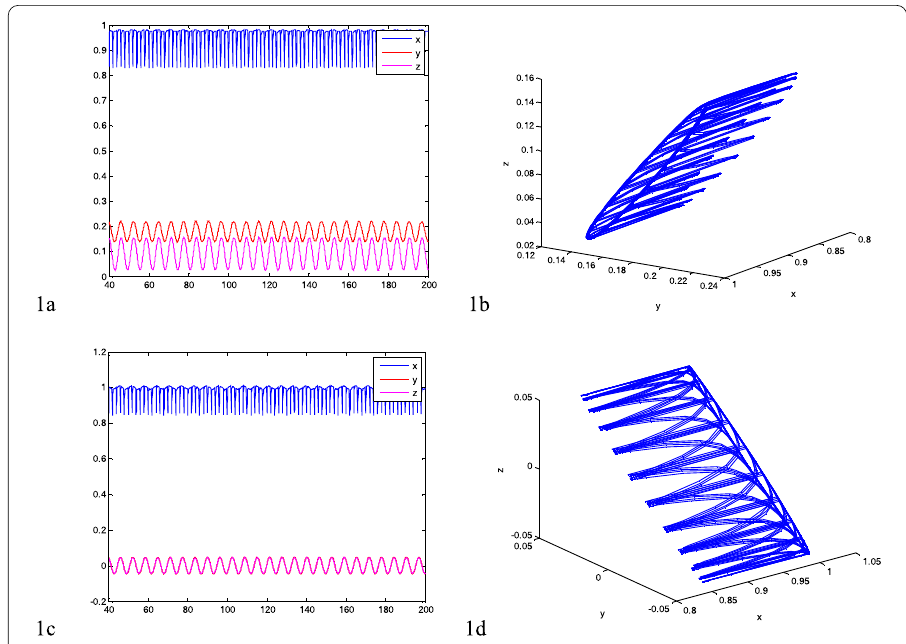
Figure 1 The dynamic behavior of system (1.2) with initial values of x (0) = 1, y (0) = 1, z (0) = 1, ( a ) time series of x ( t ), y ( t ), z ( t ), which are simulated 100 cycles in the interval [0,200]. ( b ) phase portrait of x ( t ), y ( t ), z ( t ), the solution goes gradually into the stable state from the initial point [1,1,1]. ( c ) dynamic behavior of system (1.2) with the mutual interference of the predator m = 0.8 and the prey refuge θ = 0.7, ( d ) phase portrait of x ( t ), y ( t ), z ( t ), other parameters are the same as in Fig. 1(a)